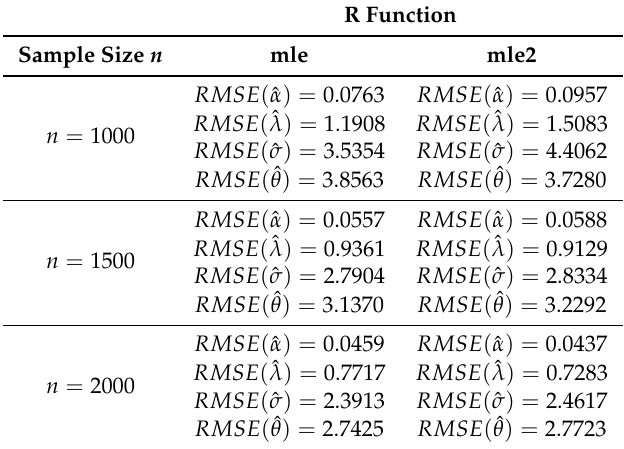
Table 3. Average root-mean-square errors (RMSE) for the composite Weibull–Pareto (CWL) model involving 1000 simulations of samples of size n for the mle function (second column) and mle2 function (third